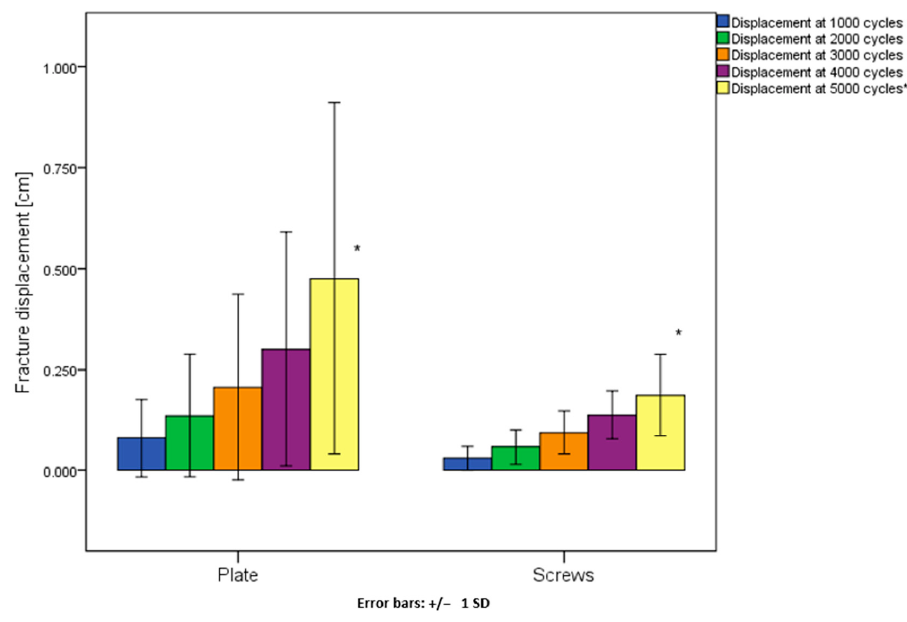
Figure 5. Fracture displacement after 1000, 2000, 3000, 4000 and 5000 cycles in group 1 (plate) and group 2 (screws) presented in terms of mean value and standard deviation. Significant difference between the groups after 5000 cycles is indicated with an asterisk (*).